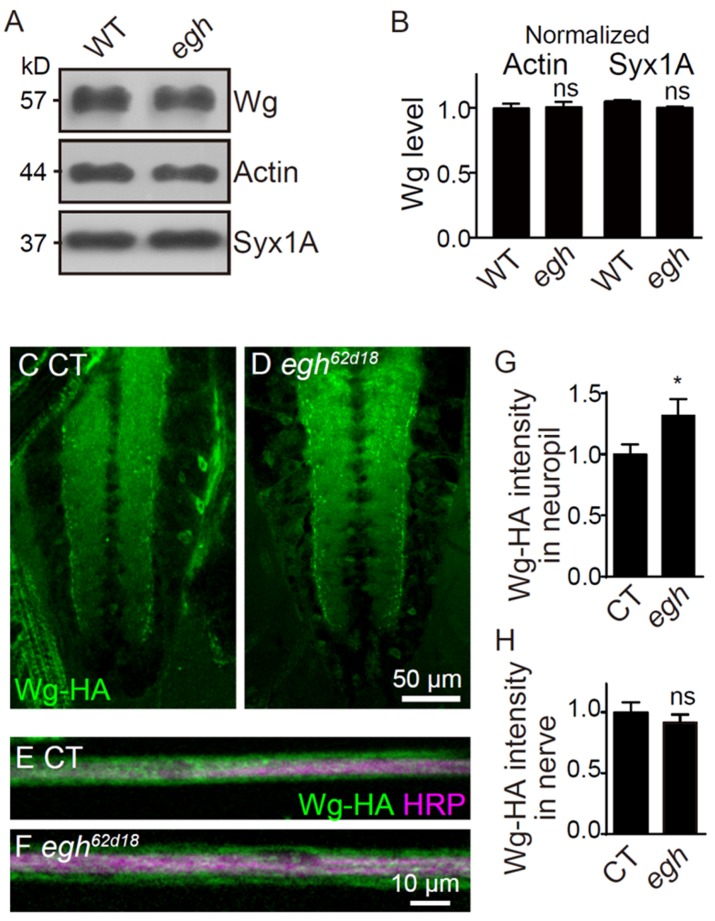
The Wg level in egh brains by immunochemical analysis.(A and B) Western blotting and quantification of Wg from 3rd instar larval brains of wild type and egh62d18 mutants, normalized to the level of Actin and Syntaxin 1A (Syx1A). n = 3; ns, no significance by one-way ANOVA test; error bars: s.e.m. (C and D) Images of ventral nerve cord stained with anti-HA in UAS-Wg-HA/+; nSyb-Gal4/+ (control, C) and egh62d18/Y; UAS-Wg-HA/+; nSyb-Gal4/+ (D). Scale bar: 50 μm. (E and F) Images of segmental nerve stained with anti-HA (green) and anti-HRP (magenta) in UAS-Wg-HA/+; nSyb-Gal4/+ (control, E) and egh62d18/Y; UAS-Wg-HA/+; nSyb-Gal4/+ (F). Scale bar: 10 μm. (G and H) Quantifications of HA intensity in neuropils and segmental nerves of control and egh mutants. n ≥ 8 larvae; ns, no significance, *p<0.05 by student’s t test; error bars: s.e.m.